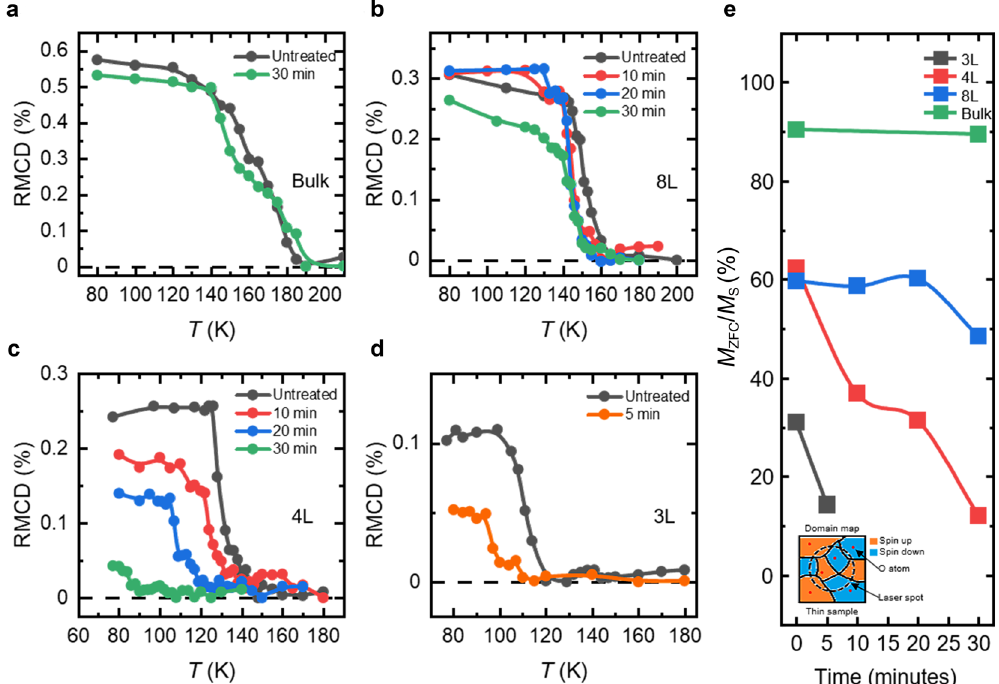
Fig. 2 Temperature-dependent RMCD of Fe 3 GeTe 2 of different thicknesses with progressive treatments and the treatment- and thickness-dependent magnetic domain behaviors. a – d Temperature-dependent RMCD of bulk, 8 L, 4 L, and 3 L Fe 3 GeTe 2 with progressive treatments, respectively. The temperature-dependent measurements are done in the zero- fi eld cooling process. e Ratio of the zero- fi eld cooling induced magnetization and the saturated magnetization at 80 K as a dependence of the treatment duration for 8 L, 4 L, and 3 L Fe 3 GeTe 2 samples, respectively. For bulk samples, the data in ( e ) is taken at 120 K, as the coercivity fi eld of bulk Fe 3 GeTe 2 at 80 K becomes larger than our affordable magnetic fi eld. The inset of ( e ) is an illustration of multiple magnetic domains in 2D Fe 3 GeTe 2 , promoted by the oxygen adsorbates.